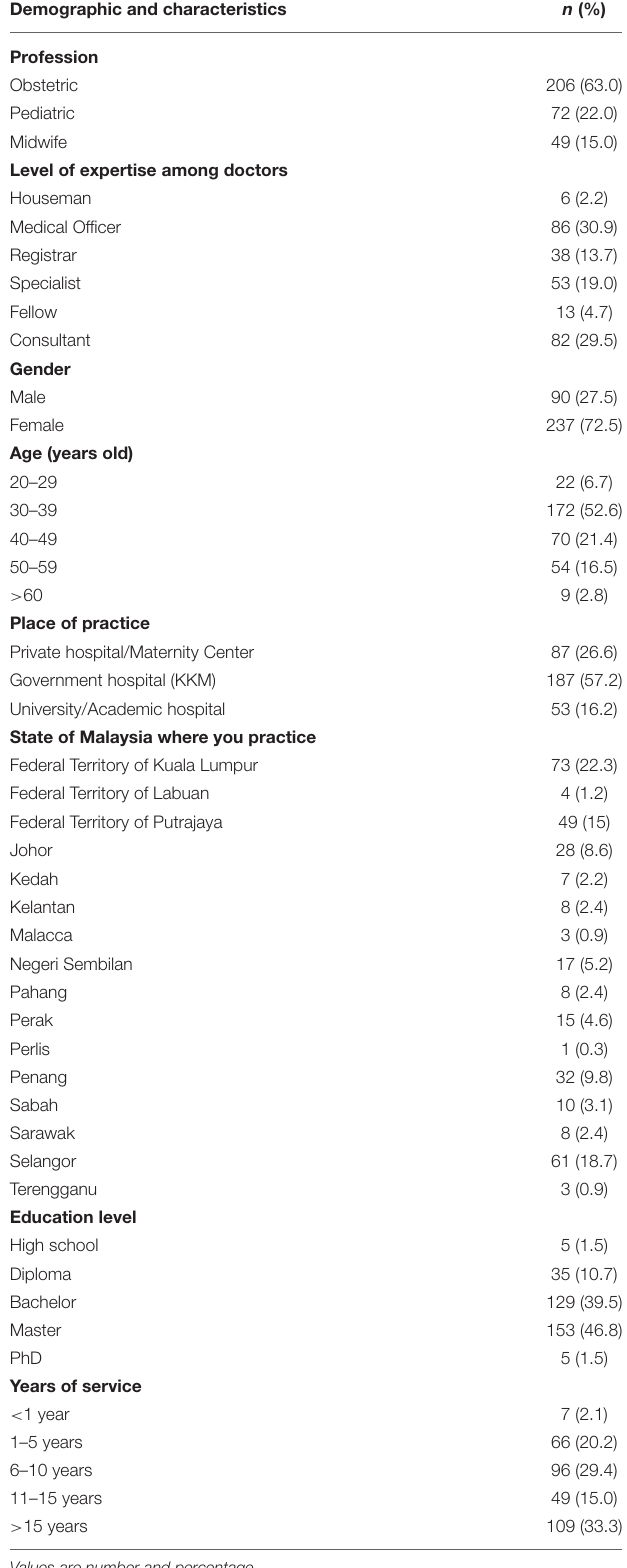
TABLE 1 | Demographic and characteristics of respondents ( n =